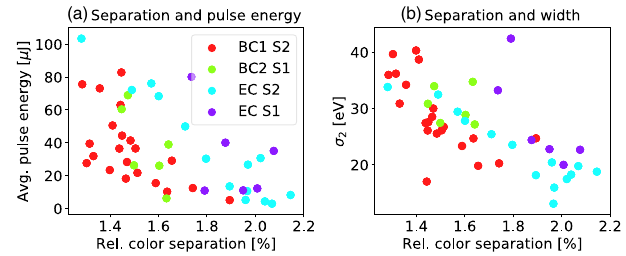
FIG. 6. Properties of the two-color scheme measured with monochromator scans, while varying the strengths of four sextupoles and the orbit adjustment factor. A: color separation and average FEL pulse energy. B: color separation and width of the second